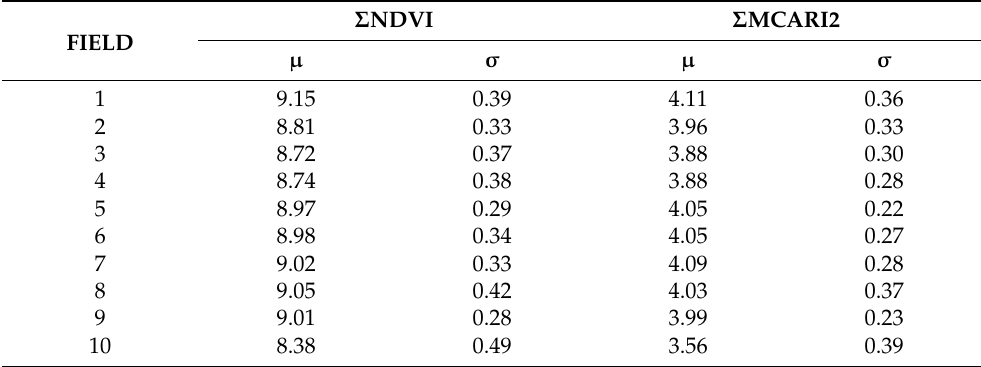
Table 4. Mean values ( µ ) of the sum of the two spectral indices and standard deviation ( σ ) collected during 2018 and